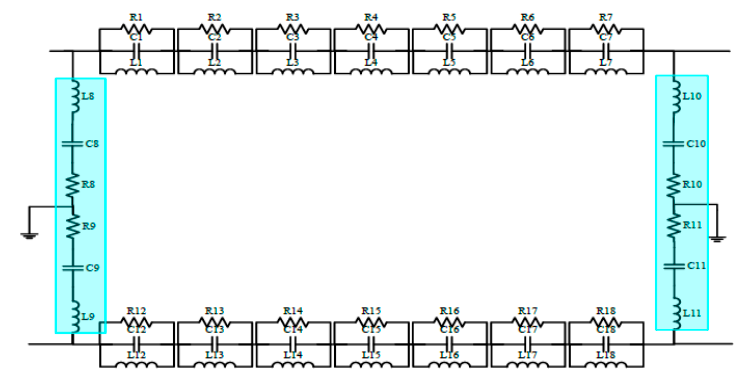
Figure 3. High-frequency equivalent model of π -type filter circuit.